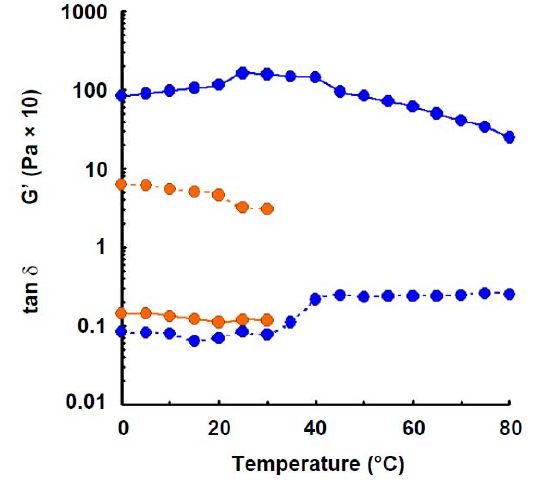
Figure 4. Effect of temperature on the elastic modulus and tan δ of wheat amylose (1.6%) with addition of urea (4.0 M). Symbols: preparation in distilled water, ●; preparation with addition of urea, ●. Lines: storage modulus, solid; tan δ,